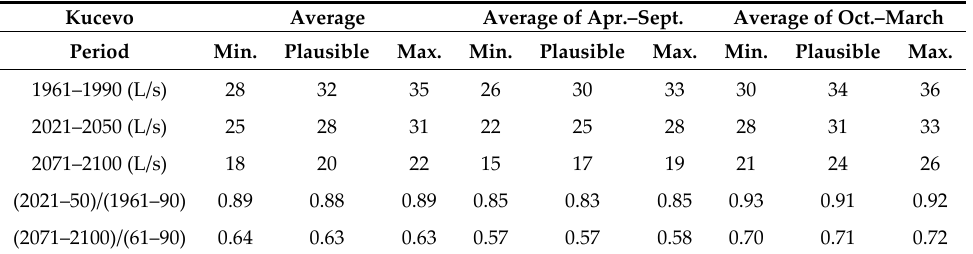
Table 4. Water Availability based on average annual hydrology at Mlaka-KU. Kucevo Average Average of Apr.–Sept.